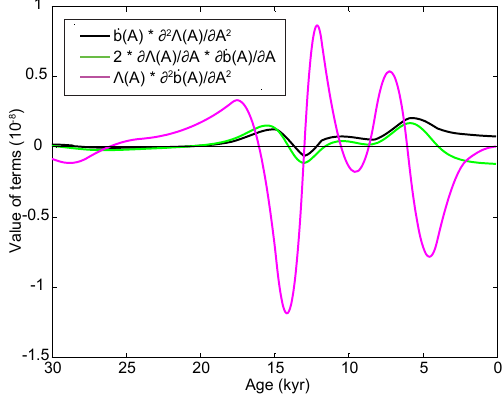
Figure B1. The three terms from the right side of Eq. (B4) evaluated for the ACCUM interpolation of WAIS Divide